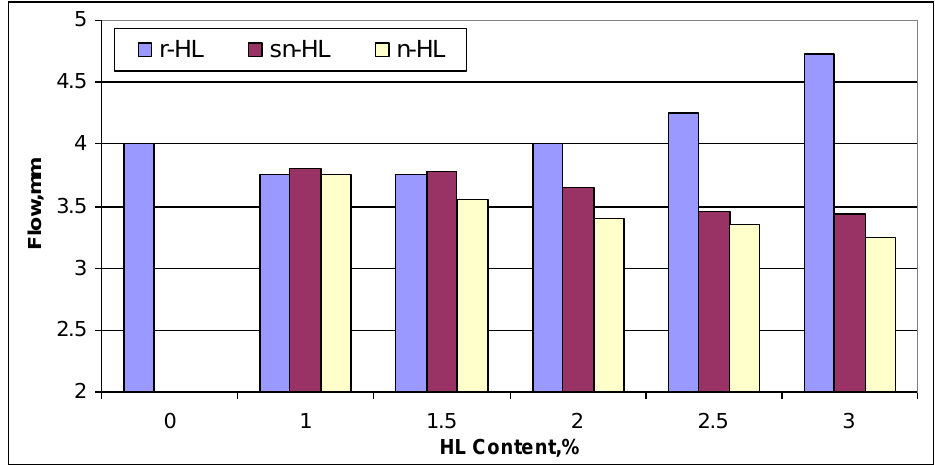
Figure 8. Comparison of Marshall flow.